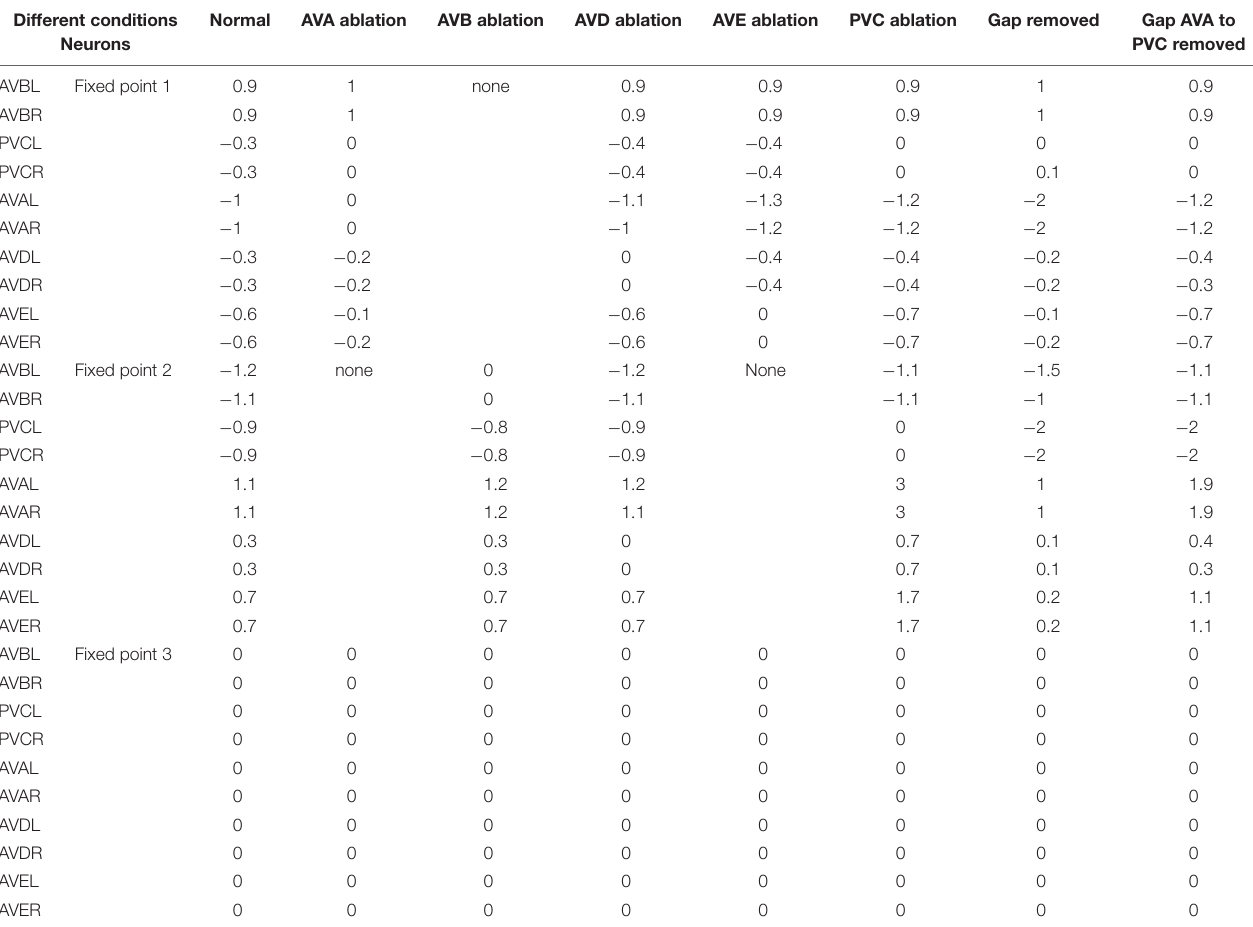
TABLE 1 | Fixed point attractors of command circuit computed under different conditions. Different conditions